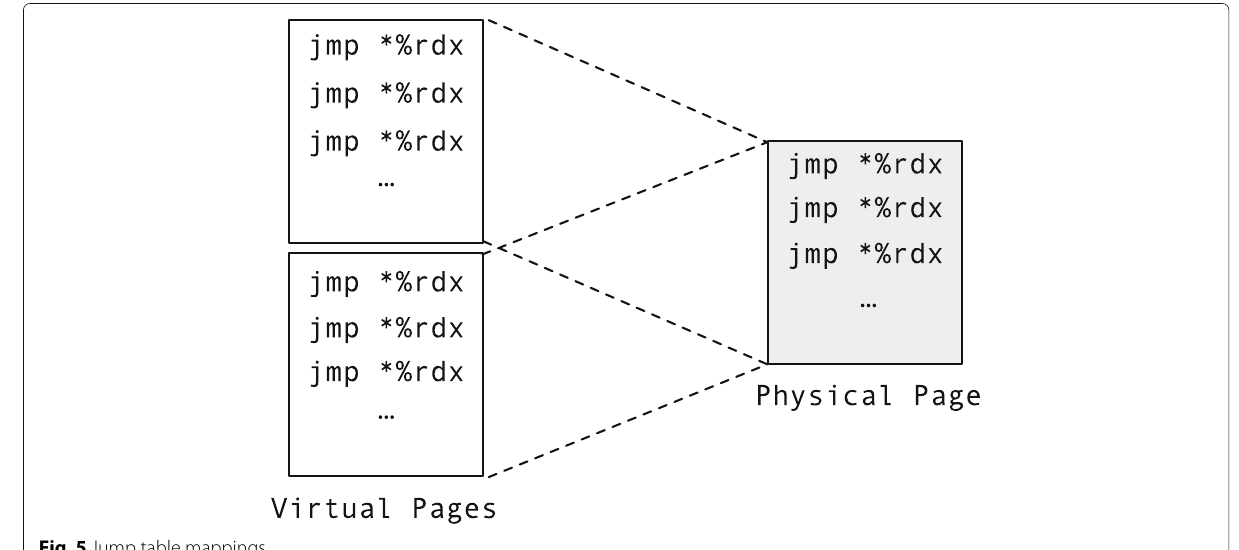
Fig. 5 Jump table mappings Implementation table. We set the content of the last jump table with retq instructions, which return directly back to the caller